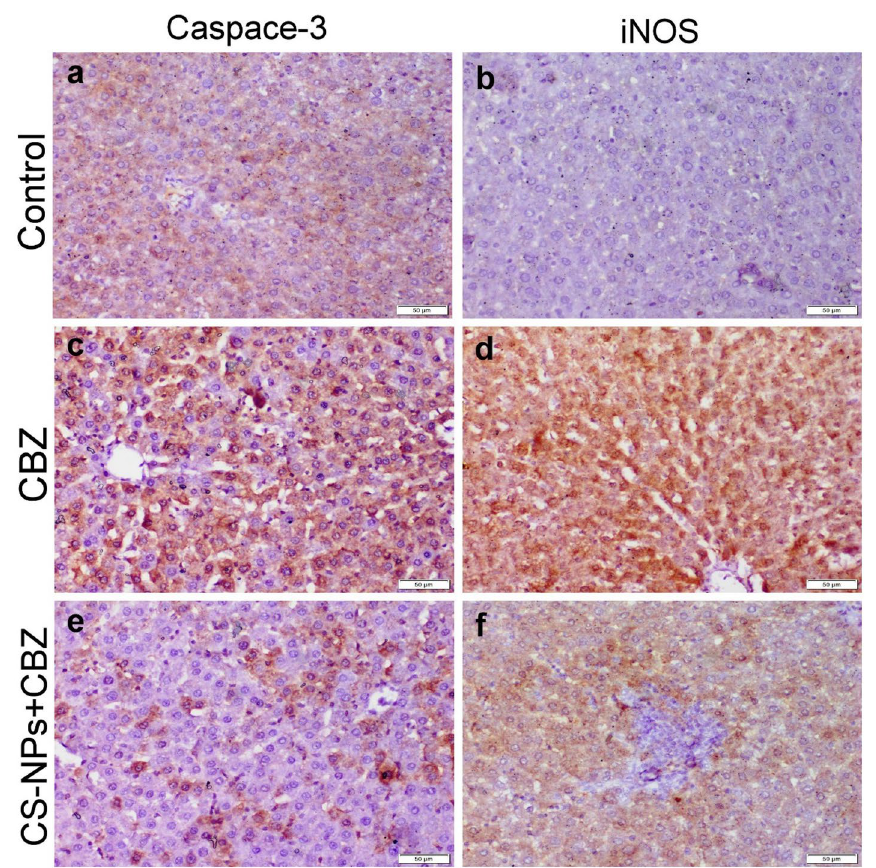
Figure 4. Photomicrograph of liver tissue sections representing the localization of casp-3 and iNOS protein in different treated groups. ( a , b ) Control negative group showing normal slight to negative casp-3 and iNOS protein expression. ( c , d ) CBZ receiving group showing strong positive casp-3 and iNOS protein expression in the tubular epithelium and interstitial inflammatory cells. ( e , f ) CS-NPs + CBZ receiving group showing weak expressions of both casp-3 and iNOS